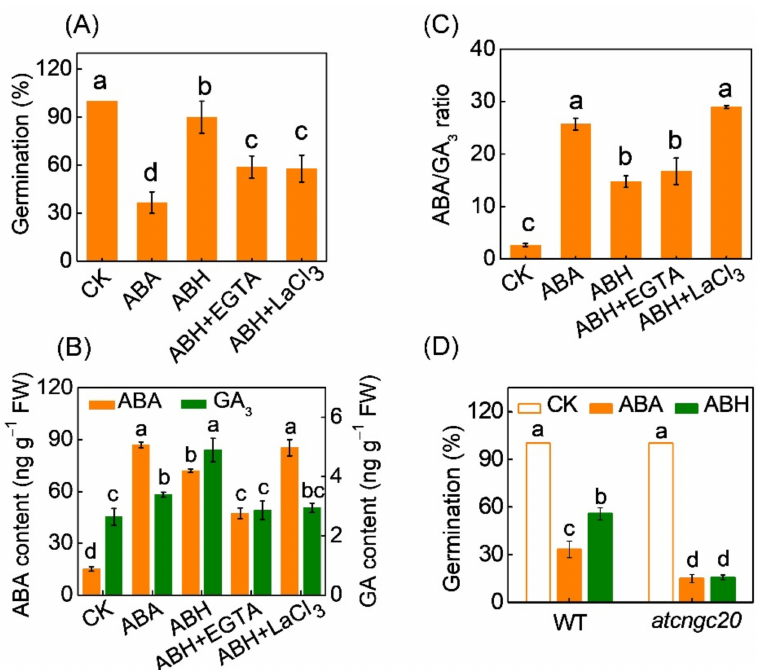
Figure 3. The role of Ca 2+ in H 2 O 2 counteracting ABA to promote seed germination. ( A ) The germination rates of melon seeds treated with ABA, a combination of ABA and H 2 O 2 (ABH), a combination of ABH and EGTA (a Ca 2+ chelator), and a combination of ABH and LaCl 3 (a plasma membrane-located Ca 2+ channel blocker). ( B , C ) ABA and GA 3 content and ABA/GA 3 ratio in melon seeds treated with ABA, ABH, ABH+EGTA, and ABH+LaCl 3 . ABA and GA 3 contents were measured on the third day after seed incubation. ( D ) The effects of ABA and ABH on the germination rates of seeds in wild-type (WT) Arabidopsis and atcngc20 mutant. In both ( A , D ), germination rates were recorded on the seventh day after seed incubation. Data are means ± SD (3 replicates × 30 seeds). The different letters denote significant difference ( p < 0.05) according to Tukey’s